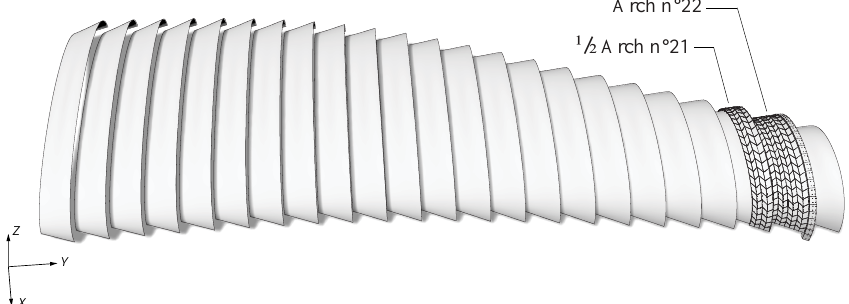
Figure 1. Illustration of the Annen Plus SA head office project in Manternach, Luxembourg consisting of 23 double-layered double-curved timber plate shells. Experimental tests were carried out on prototypes of arch n° 22 and half of n° 21.